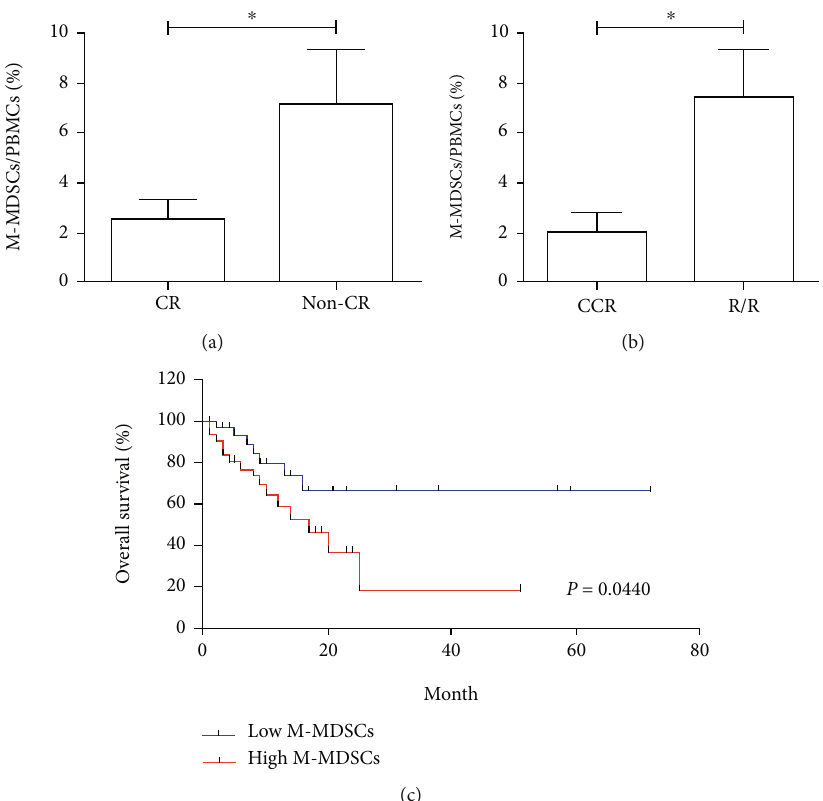
Figure 2: The prognostic relevance of circulating M-MDSCs in AML. The frequencies of circulating M-MDSCs in the CR group were signi fi cantly lower than the non-CR group (a). The frequencies of circulating M-MDSCs in the CCR group were signi fi cantly lower than the R/R group (b). The low circulating M-MDSC frequency group had a signi fi cant survival advantage compared with the high group (c). ∗ p < 0 : 05